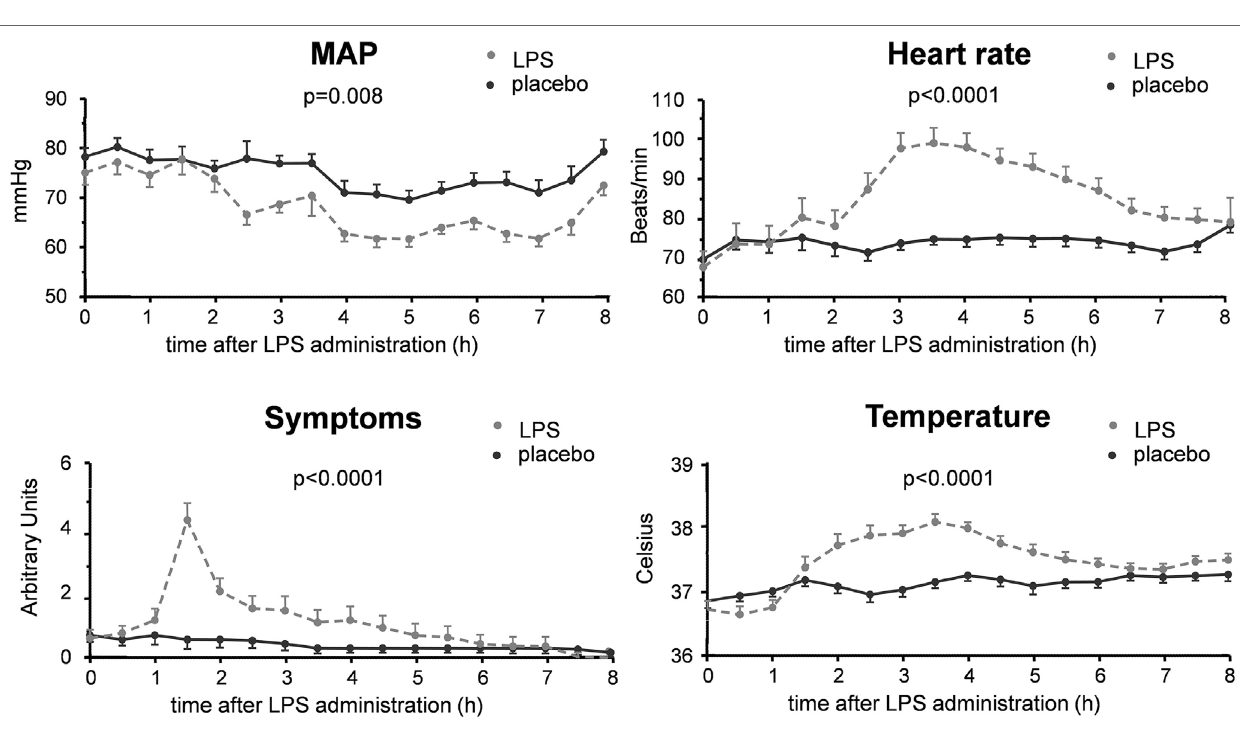
FigUre 5 | Hemodynamic and clinical parameters in 30 subjects who received an intravenous administration of lipopolysaccharide (LPS) ( n = 15) or placebo ( n = 15) at T = 0. Data are represented as mean ± SEM.